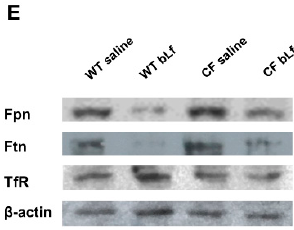
Figure 5. Changes in ferroportin ( A ), ferritin ( B ), transferrin receptor ( C ) levels in lung homogenates analyzed by Western blot and total iron content ( D ) in BALFs of WT and CF mice after 7 treatments with aerosol administration of 50 µ L sterile saline or 200 µ g / 50 µ L bLf. ( E ) Representative Western blot. Error bars: standard error of the mean. Statistical significance is indicated as follows: *: p < 0.05; **: p < 0.01 (Mann-Whitney U test). a.u: arbitrary